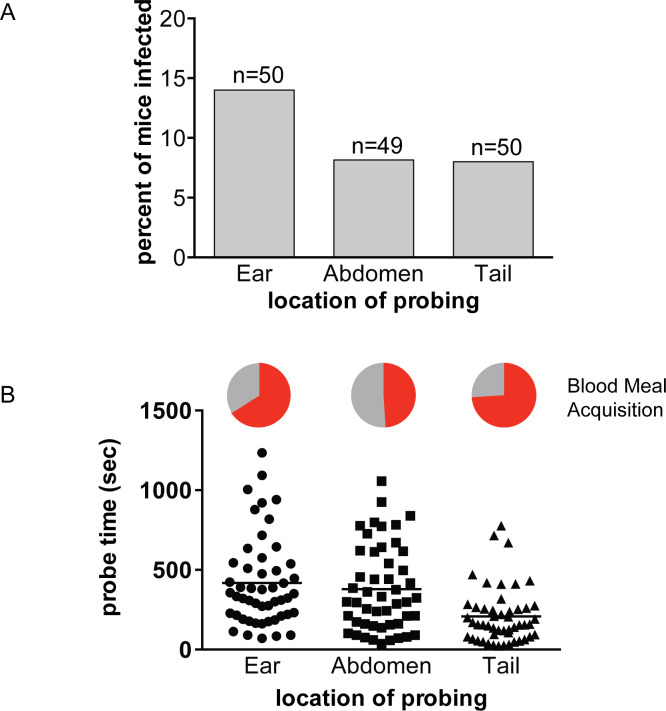
The anatomical location of mosquito probing does not impact the likelihood of malaria infection.Single-mosquito feeds were performed on the ear, abdomen or tail of mice and probe time and blood meal acquisition were recorded. Following this, salivary gland sporozoite loads were measured and mice were followed for blood stage malaria infection. (A) Percent of mice positive for malaria infection when probed-upon at the indicated location. n = total number of mouse-mosquito pairs in each group, pooled from 4 independent experiments with 10 to 15 mouse-mosquito pairs per group per experiment. The risk of infection is not statistically different between the three locations (p = 0.655). (B) Probe time and blood meal acquisition of mosquitoes placed on different anatomical locations. During the location feeds, mosquitoes were allowed to probe until they took a blood meal or became disinterested and flew away. Times to either of these endpoints were measured and were lower for mosquitoes placed on the tail compared to the abdomen and ear, by 45 to 50 percent respectively (p<0.001). Pie Charts: The percent of mosquitoes feeding on the ear, abdomen and tail that succeeded in obtaining a blood meal is shown in red and was 66%, 51%, and 74%, respectively. This difference did not reach statistical significance (p = 0.06, Fisher’s exact test).